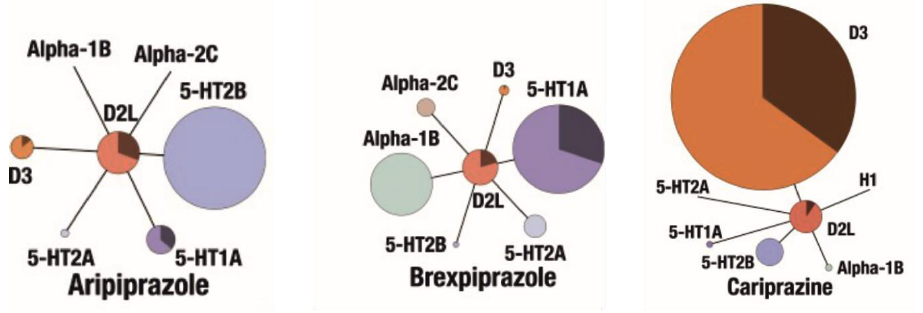
Figure 7. Pharmacological profiles of the third generation antipsychotics, elaborated on the basis of [90] with modifications.